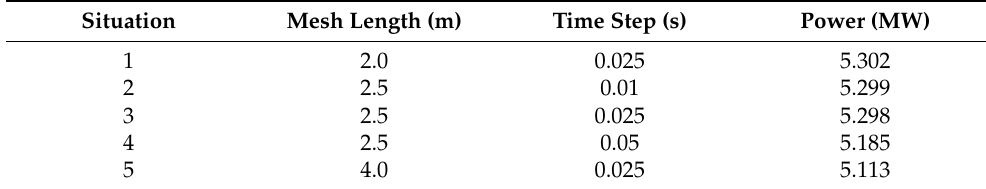
Figure 5. Velocity profiles of the hub height plane at 2D downstream of the downstream turbine. Table 2. Grid and time step independent